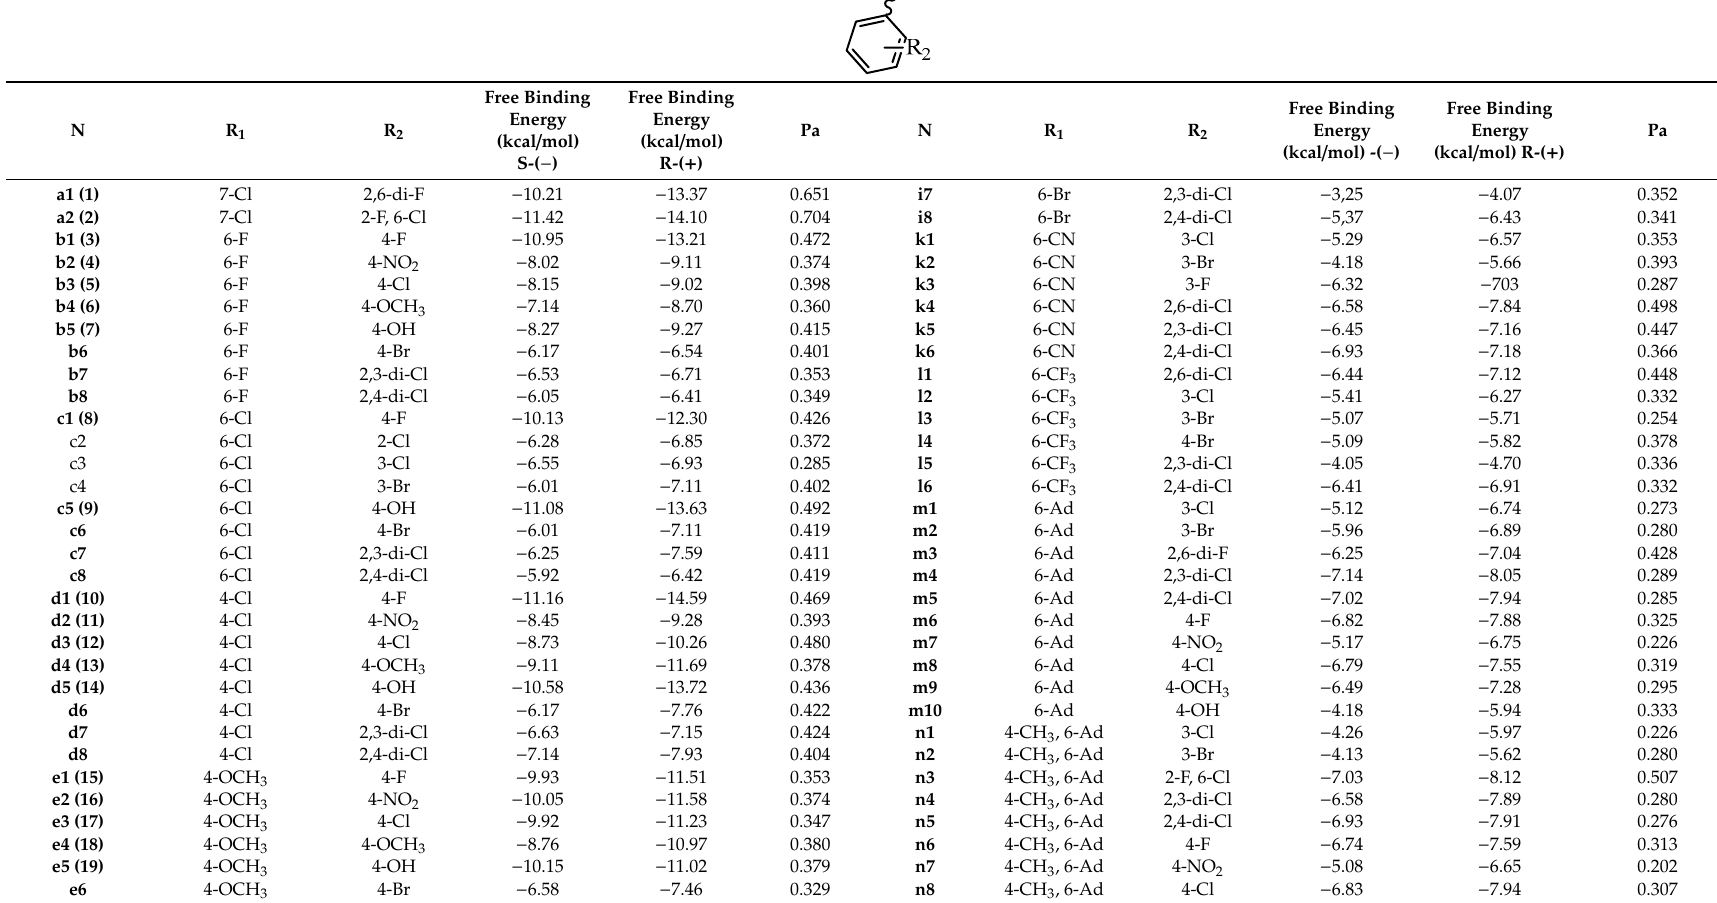
Table 1. Molecular docking scores and PASS prediction of all the designed compounds.